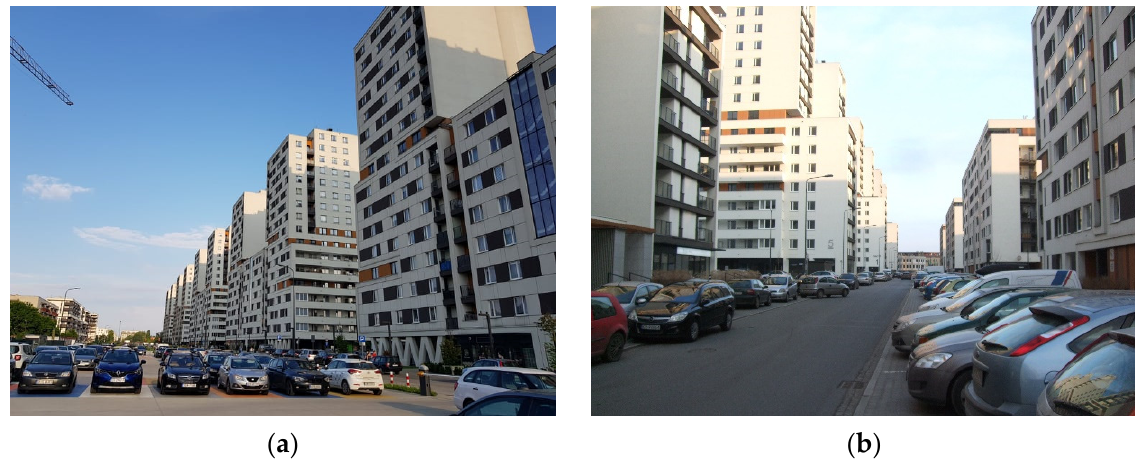
Figure 9. Character of an open space in the multi-family residential development in Czy ż yny: ( a ) Arrangement of the area of the former runway of the Rakowice-Czy ż yny airfield along with the residential development; ( b ) Character of a space in between the buildings. Photos: by author.